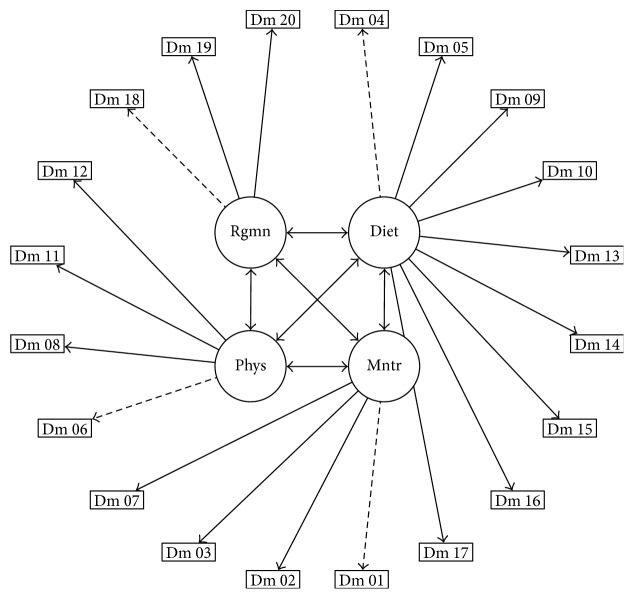
The measurement model for the CFA of T-DMSES based on a four-factor structure including regimen self-efficacy (regimen), diet management self-efficacy (diet), physical activity self-efficacy (physical), and monitoring self-efficacy (monitor).